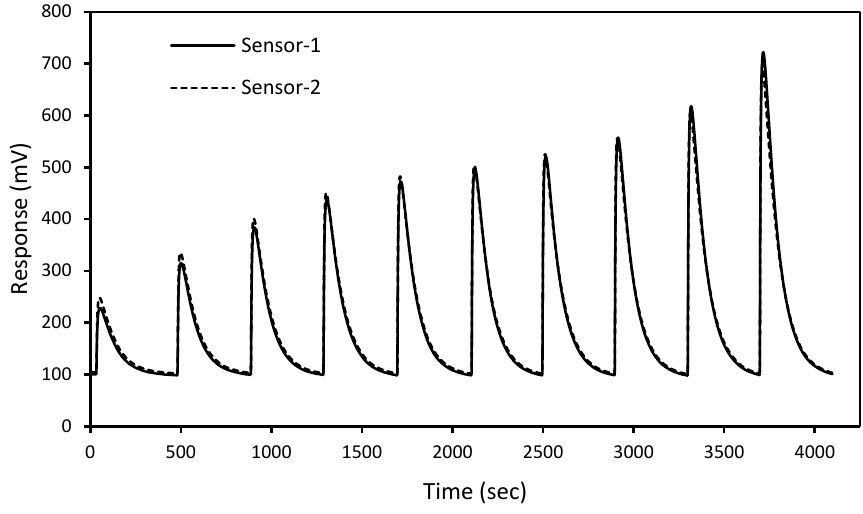
Figure 3. Dynamic response of gas sensors.